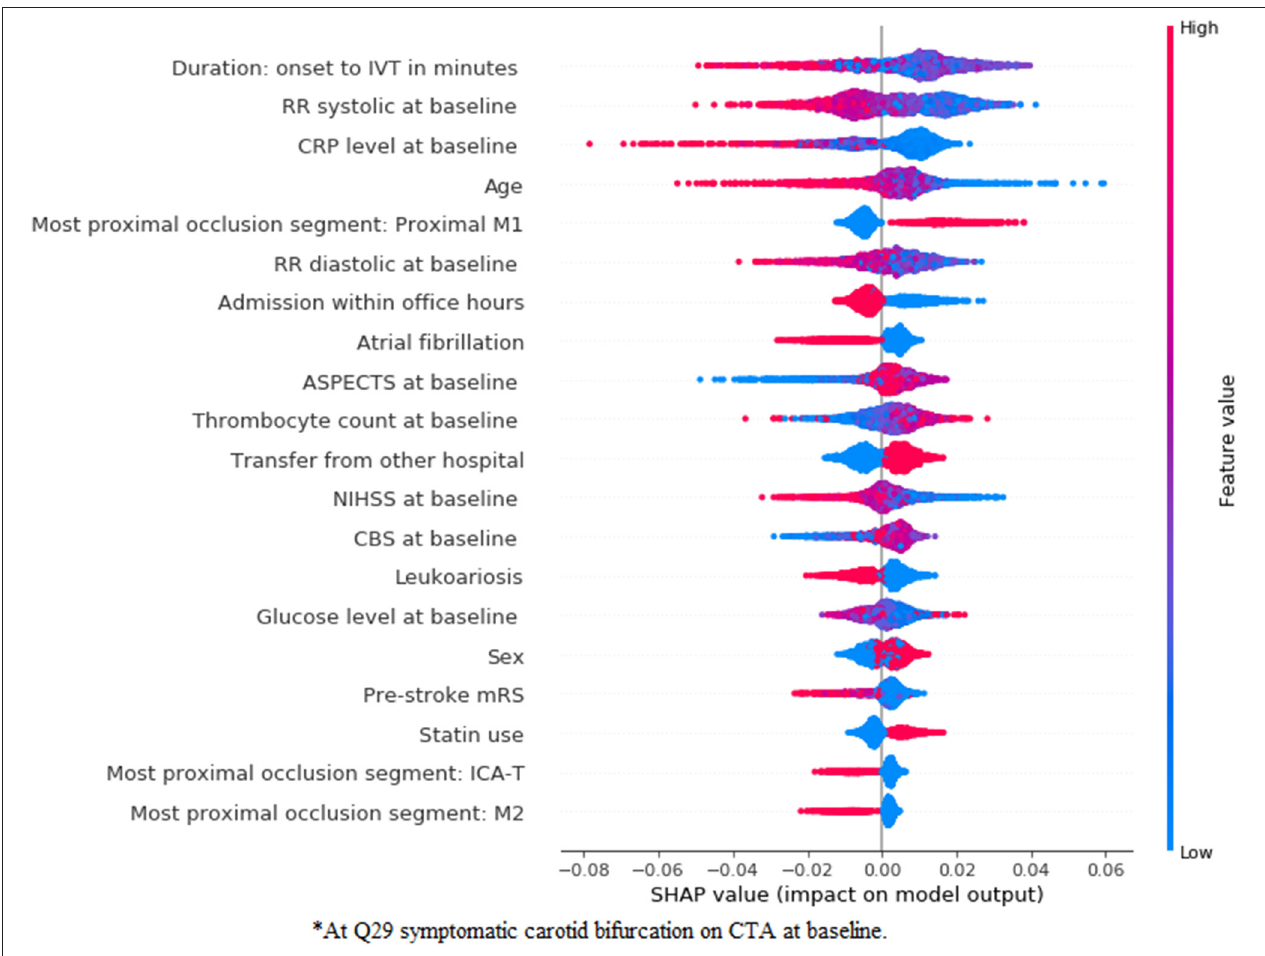
FIGURE 7 | SHapley Additive exPlanations feature importance for the clinical experiment for the prediction of good reperfusion using an RFC model. For visualization purposes we included only the top 20 features. Features are shown in order of importance, from most important (top) to less important (bottom). The color legend on the right shows how the feature values influence outcome: high values are depicted in red, while low values are presented in blue. Positive SHAP values (above zero in the x -axis) mean that the feature values are associated to the positive outcome (in this case good r), while SHAP values below zero indicate the opposite. * At symptomatic carotid bifurcation on CTA at